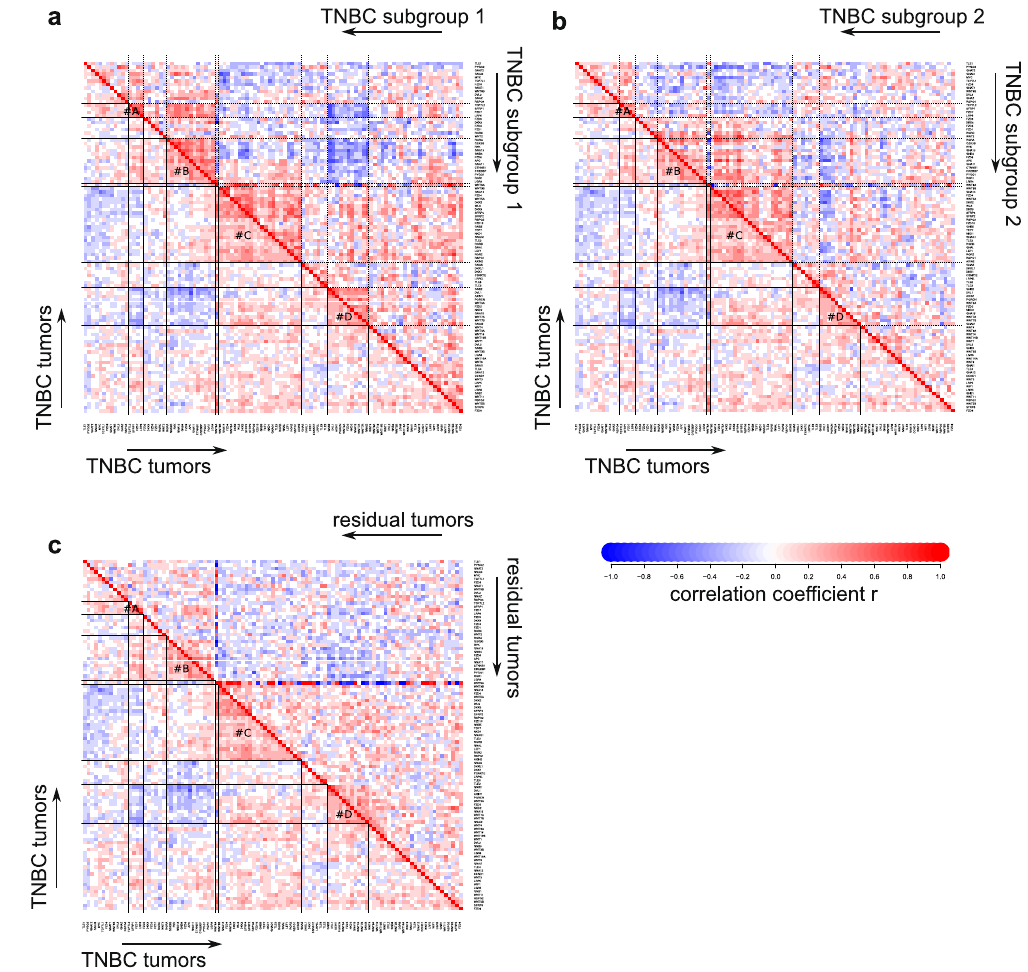
Figure 5. Heatmaps comparing initial set of TNBC tumors with subgroups obtained upon search for subgroups with increased number of correlation. Panel (a) compares subgroup 1, panel (b) subgroup 2 and panel (c) shows tumors which do not belong to any subgroup (“residual tumors”). Most of the clusters identified in original TNBC set remain and show increased component